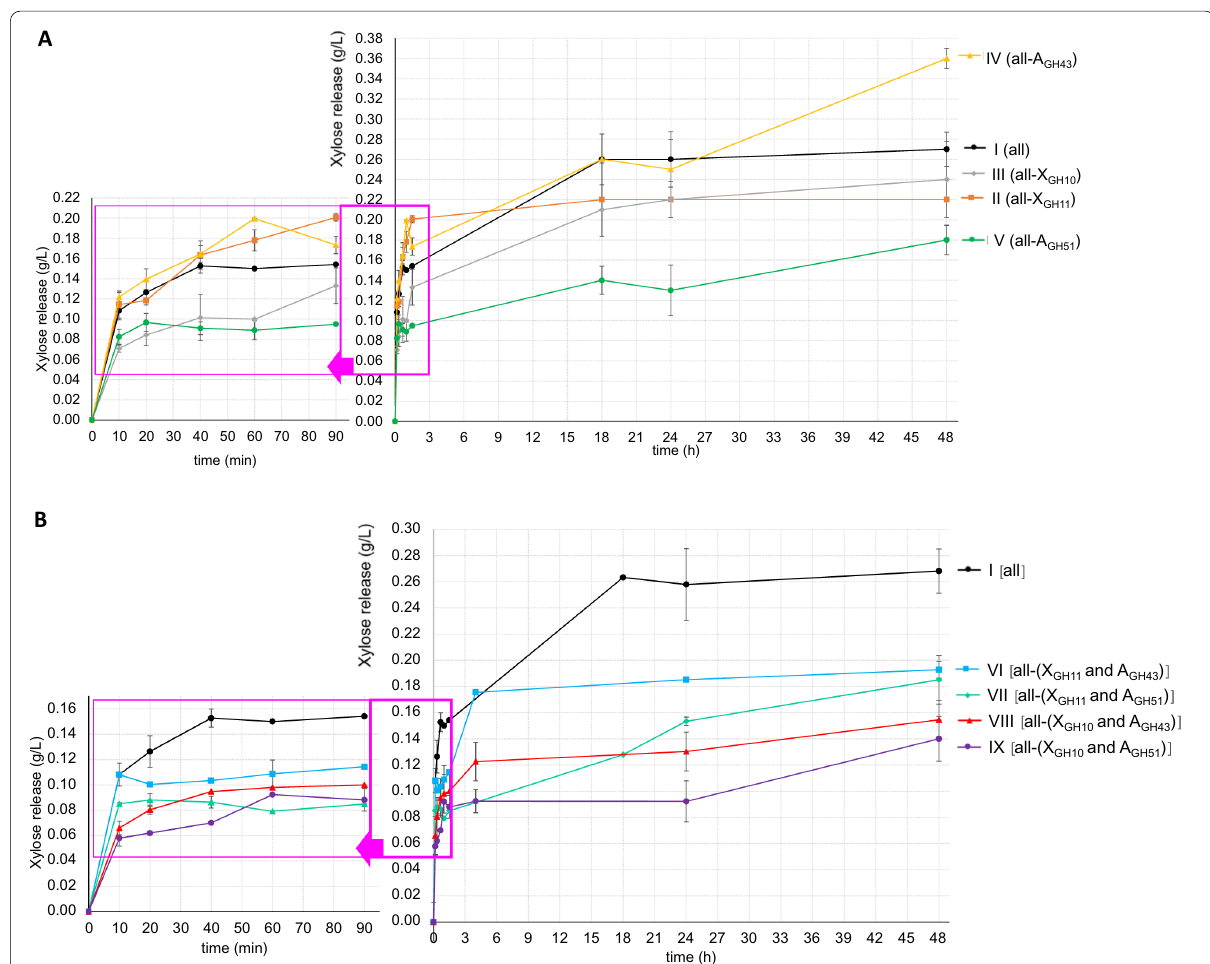
Fig. 3 Xylose release from enzymatic hydrolysis. A Assays with all enzymes (I) versus assays without one enzyme (II to V). B Assays with all enzymes versus assays without two enzymes (VI to IX). Values represent the mean of two independent experiments, and error bars correspond to the standard deviations